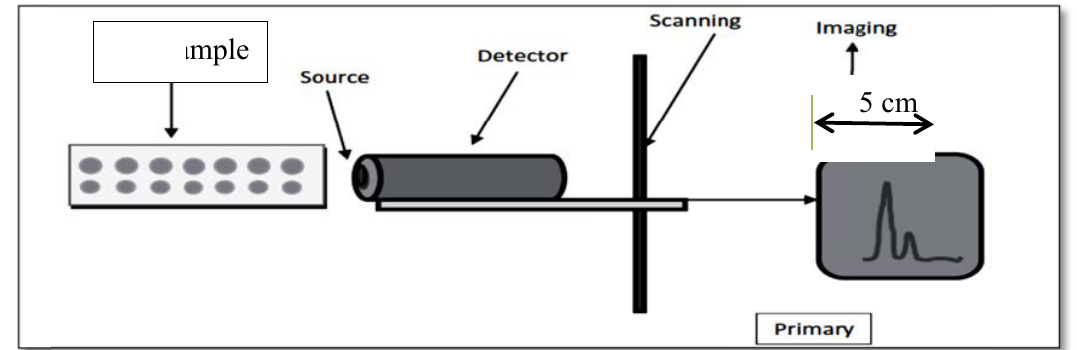
Fig.1: Setup f n direct conta